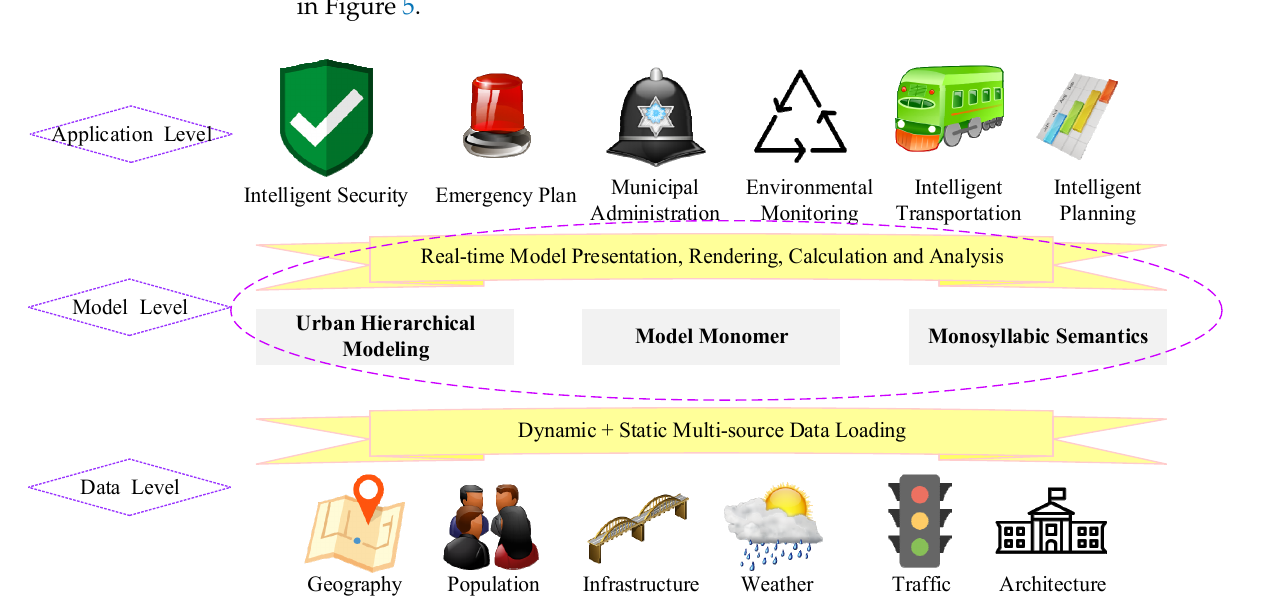
Figure 5. DTs+ urban operation management architecture.